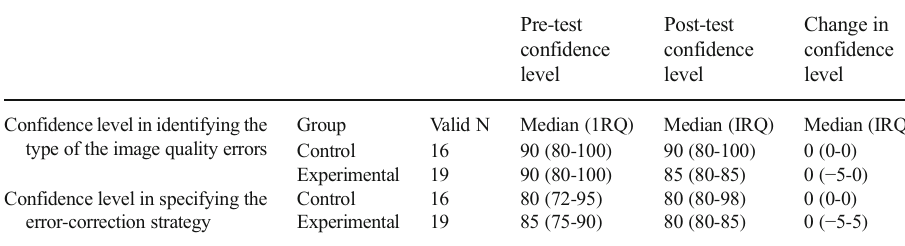
the confidence level in identifying the type of the image quality errors and specifying an appropriate error-correction strategy for both